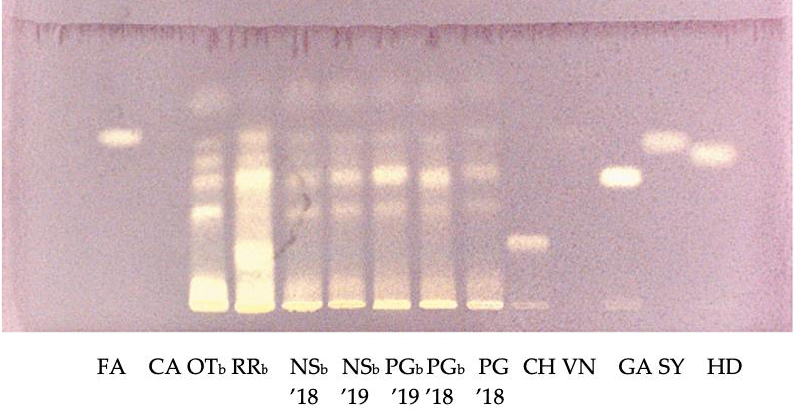
Figure 4. HPTLC patterns of the composition of phenolic compounds of the ethanol fraction of corn varieties detected at visible light after derivatization with DPPH solution. Standard phenolic acids are run in parallel. FA: ferulic acid, CA: coumaric acid, CH: chlorogenic acid, VN: vanillic acid, GA: gallic acid, SY: syringic acid, HD: dihydroxybenzoic acid, OTb: Ottofile brown 2019, RRb: Rosso di Rovetta brown, NSb ’18: Nostrano Isola brown 2018, NSb ’19: Nostrano Isola brown 2019, PGb ’19: Pignoletto brown 2019, PGb ’18: Pignoletto brown 2018, PG ’18: Pignoletto 2018.